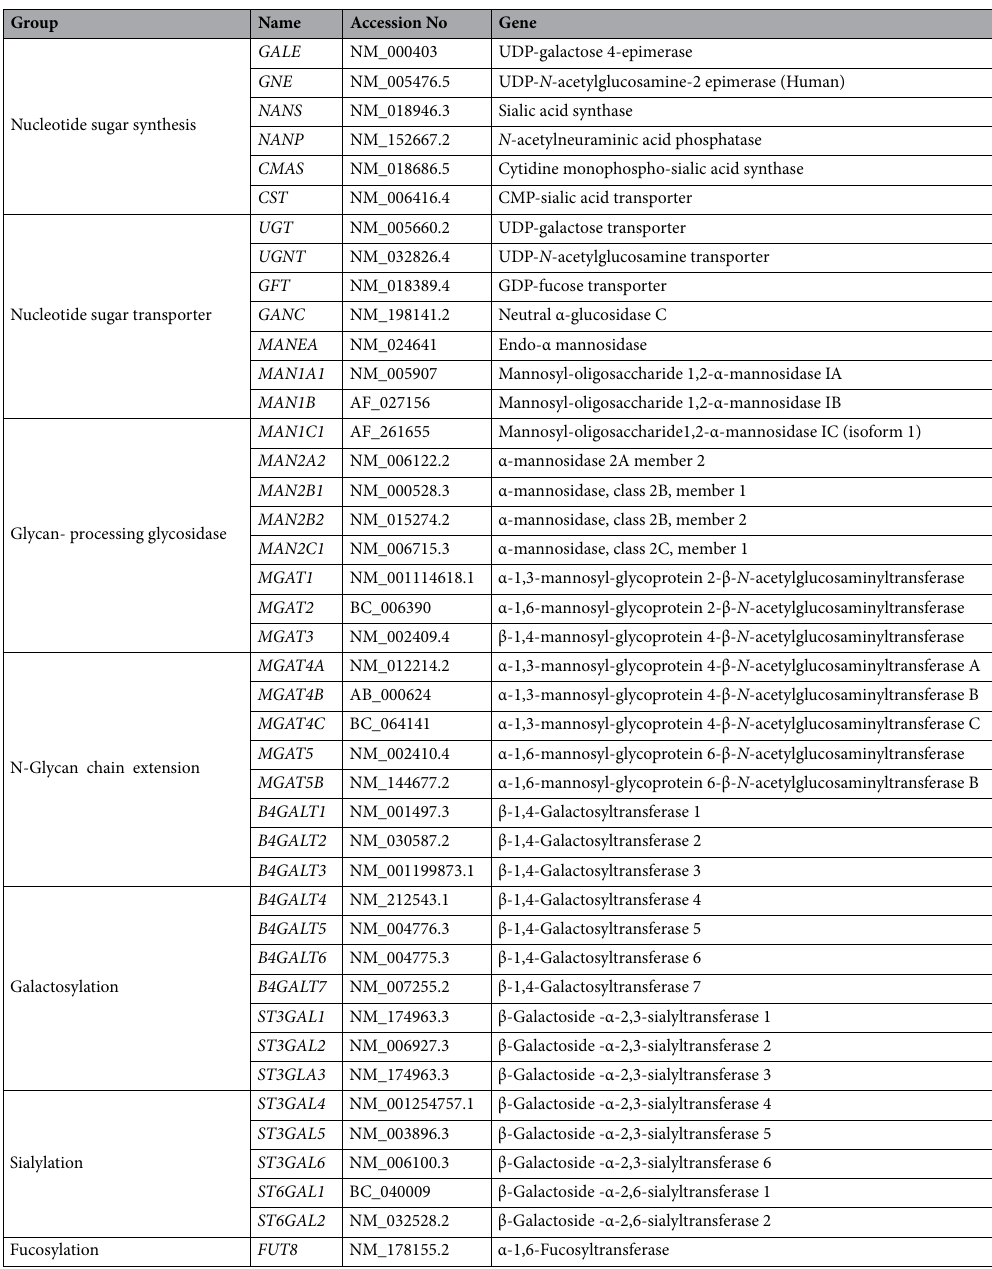
Table 1. List of human glycosyltransferase genes used in the